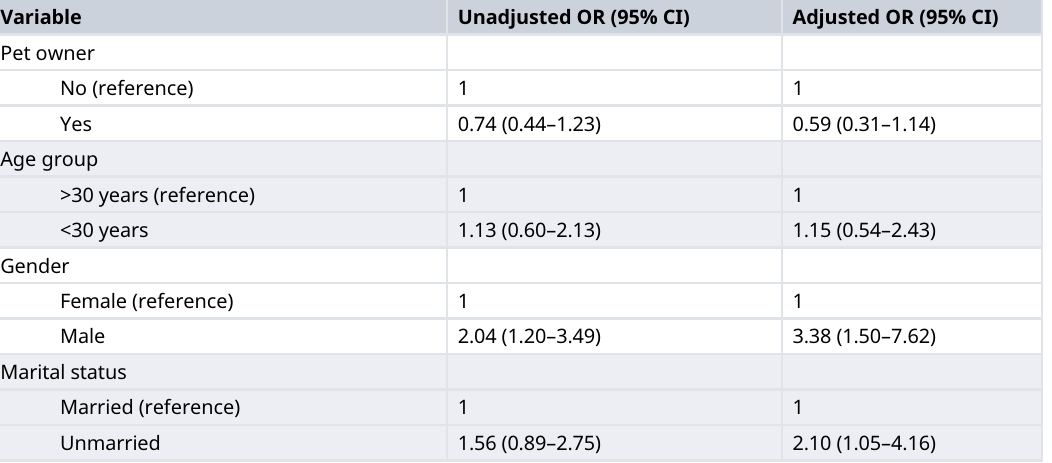
Table 3. Bivariate logistic regression predicting depression